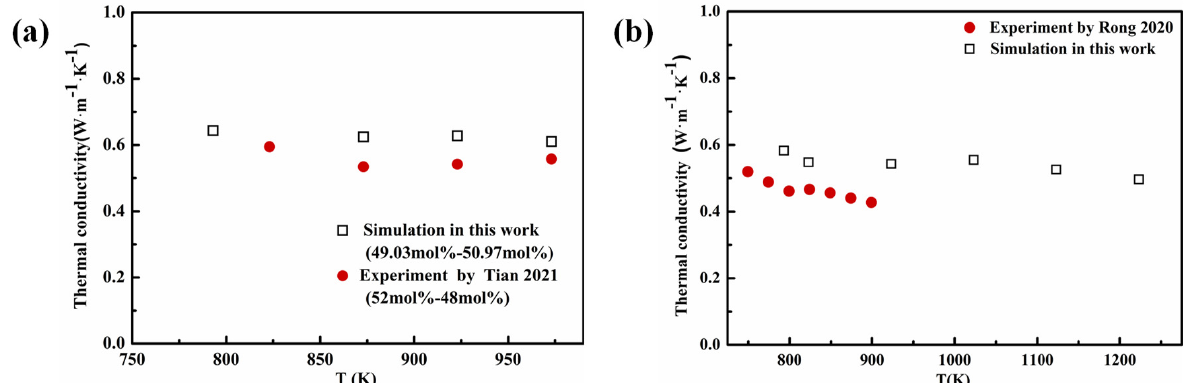
Figure 6. Thermal conductivity of chloride eutectic molten salts of ( a ) binary NaCl ‐ CaCl 2 and ( b ) ternary NaCl ‐ CaCl 2 ‐ MgCl 2 vs. temperature [5,9].